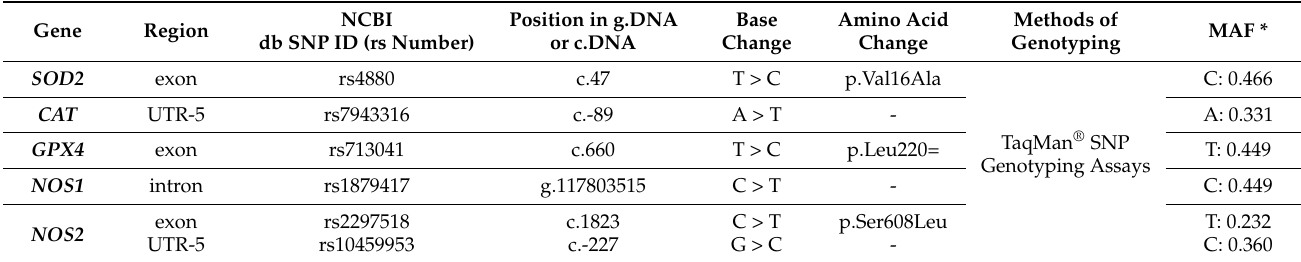
Table 1. Basic information of the SOD2 , CAT , GPX4 , NOS1 and NOS2